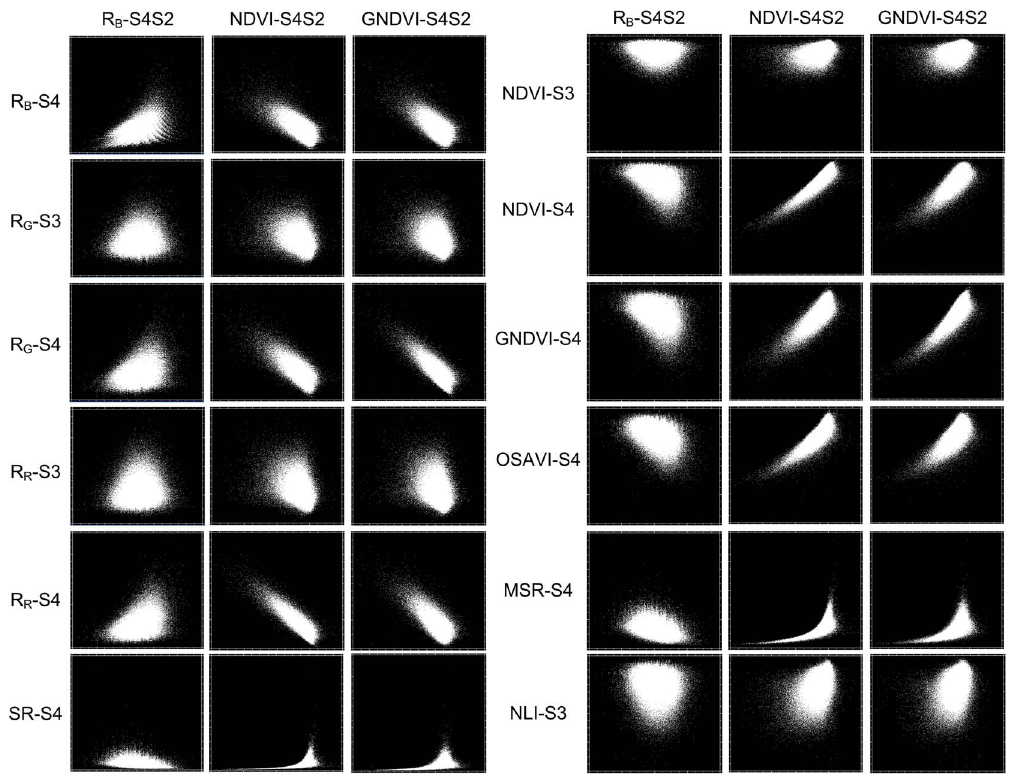
Figure 6. Scatter plots of all pairs of single-stage spectral features versus multi-stage spectral features. The scatter points in each plot represented all pixels within the winter wheat planting area.